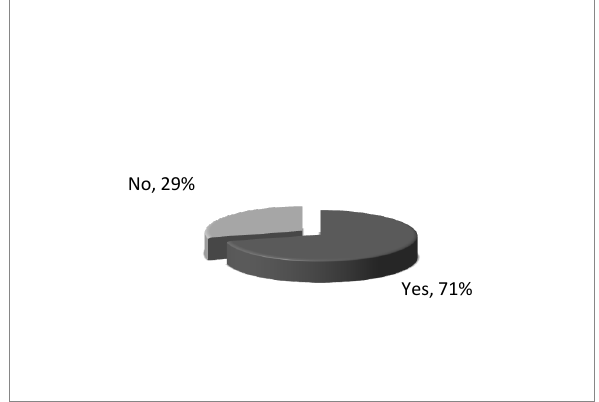
FIGURE 7: Contract of service between employee and employer, 2008 Source: Survey data